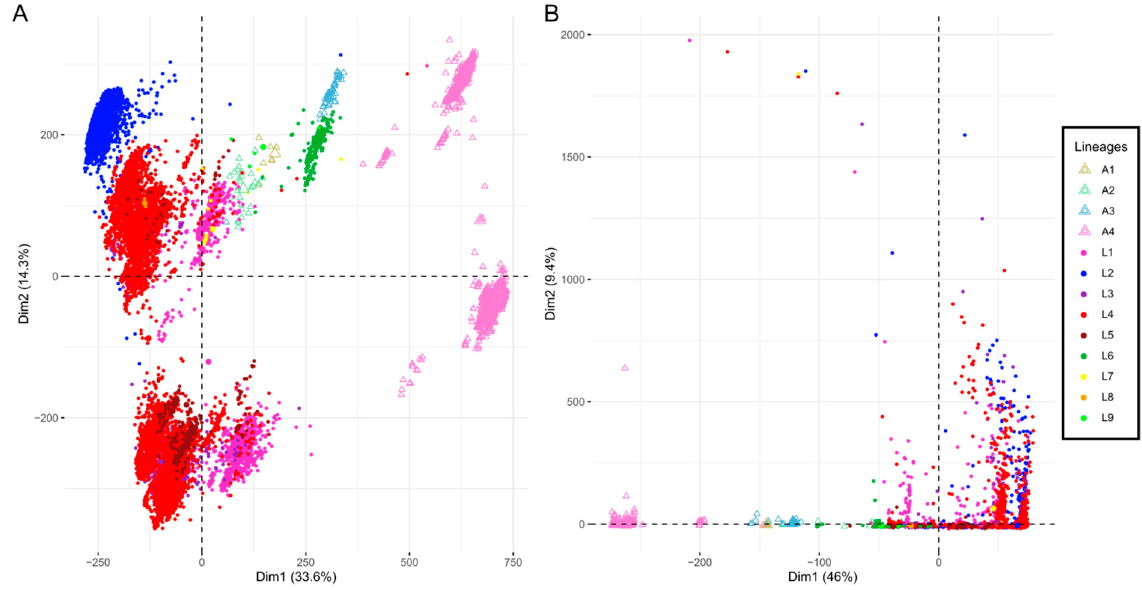
Figure 1. Principal Component Analysis of ORF deletion percentage. ( A ). All ORFs. ( B ). ORFs annotated as enzyme-coding. Each point represents a genome, which is colored according to the lineage it belongs to.